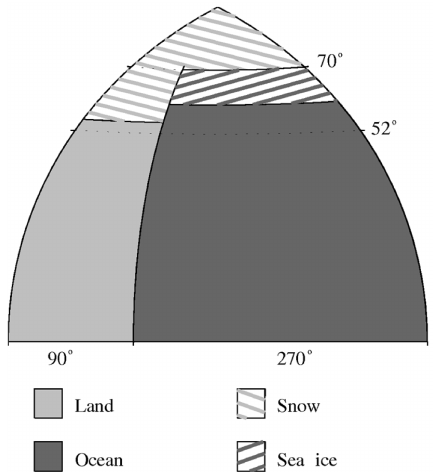
Figure 2. Model configuration. The model consists of one hemi- sphere divided by 52 ◦ latitude into 360 ◦ wide, low–mid-latitude (LL) and high-latitude (HL) sectors. Values for global reservoirs, transports and fluxes are twice the hemispheric values. The model ocean is 270 ◦ wide and extends from the Equator to 70 ◦ latitude. The ocean covers 70.5% of the model surface. LL and HL ocean sectors have the area ratio 84 : 16. Sea ice and snow coverage are diagnosed from idealized, meridional profiles of atmospheric tem-